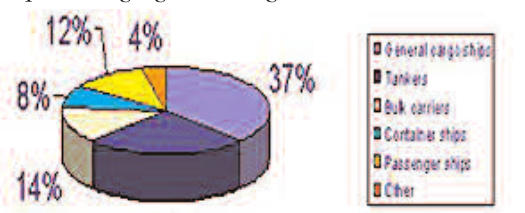
Figure 2. Number of Ships (by total and trade) Different sectors as percentage of total number of ships in world